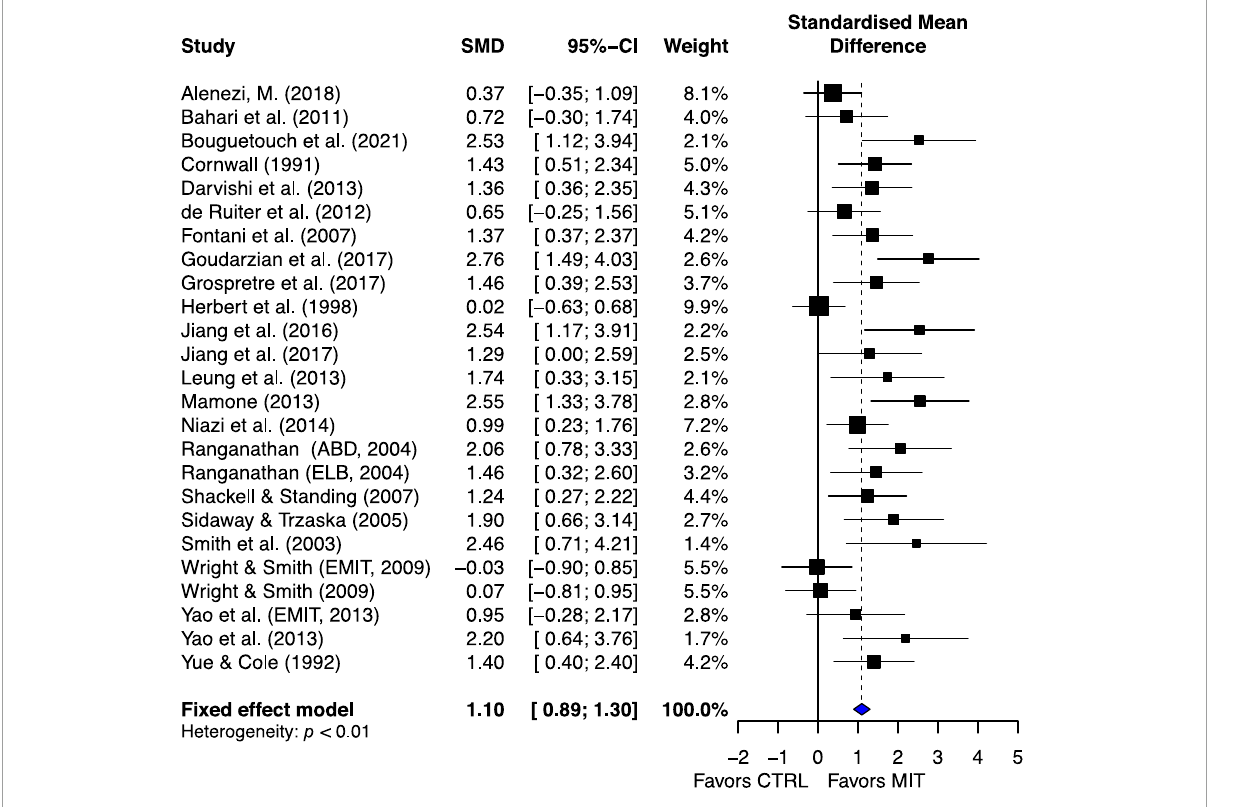
FIGURE3 Effects on maximal muscle strength: Mental imagery training (MIT) vs. control group